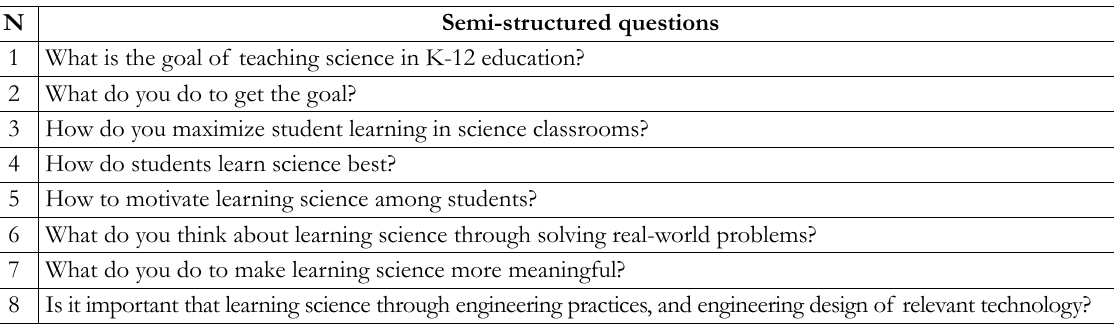
Table 5. Semi-structured questions for the school principals’ belief